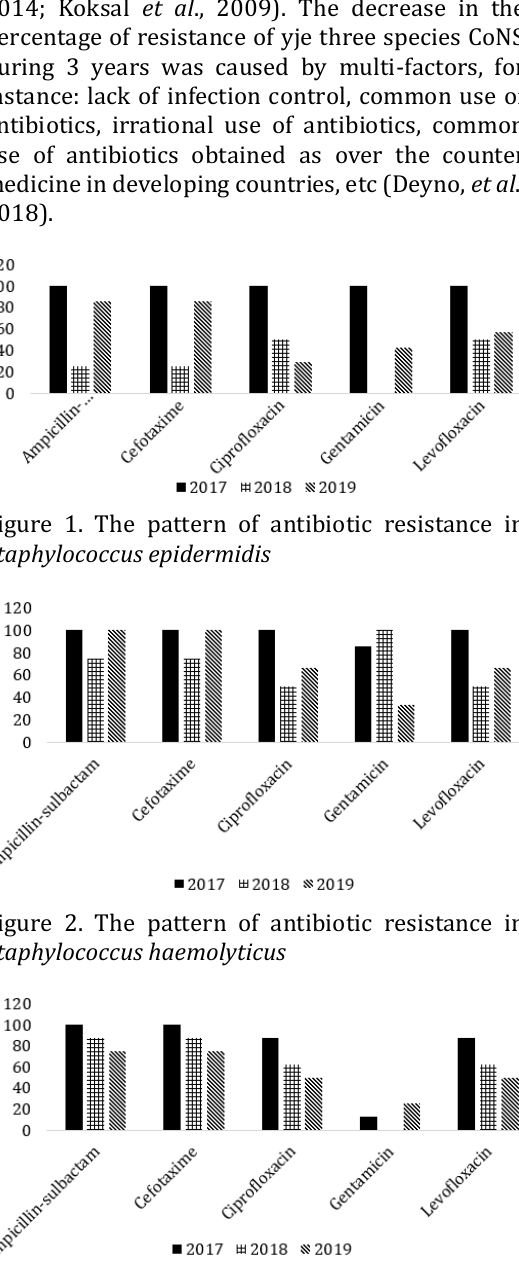
S. haemolyticus fluctuated during the 3